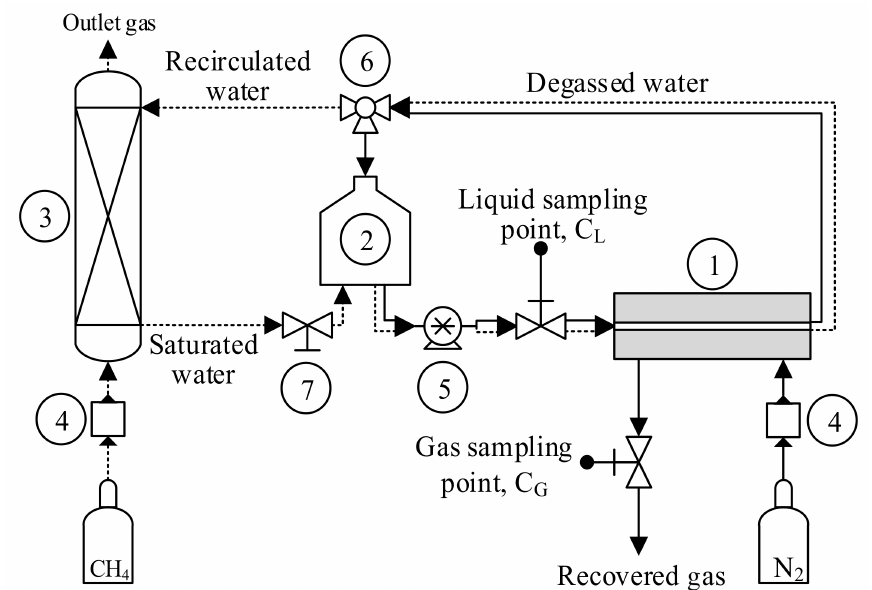
Figure 2. Scheme of the experimental system for dissolved methane degassing tests from aqueous streams with a flat-sheet membrane module. (1) membrane module, (2) liquid feed tank, (3) saturation column, (4) mass flow controller, (5) peristaltic pump, (6) 3-way valve, and (7) on/off